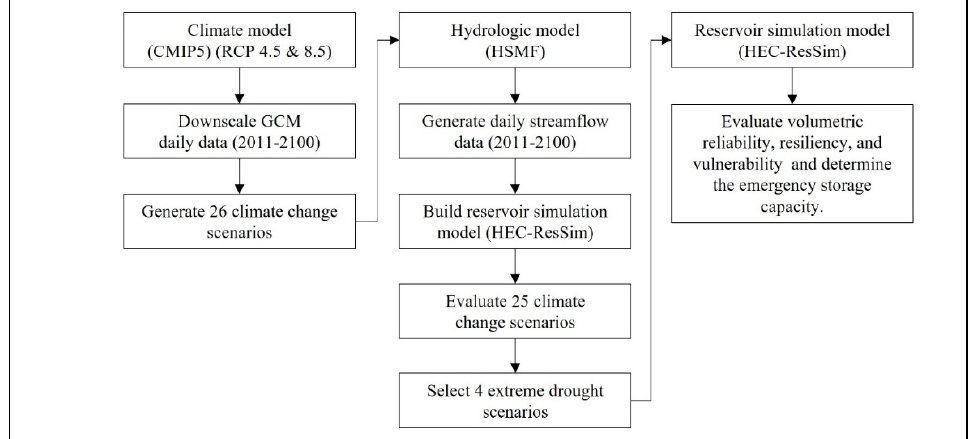
Figure 4. Workflow for building, calibrating, and validating the climate model, hydrologic model, and reservoir model. We build and simulate five reservoirs using HECResSim.